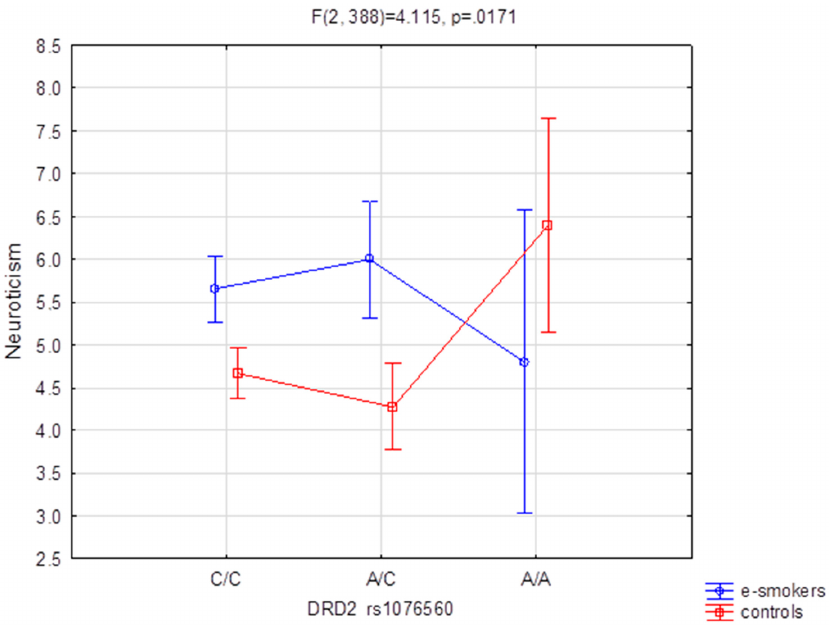
Figure 1. The group (e-cigarette users vs controls) DRD2 rs1076560 polymorphism interaction for the NEO FFI Neuroticism.